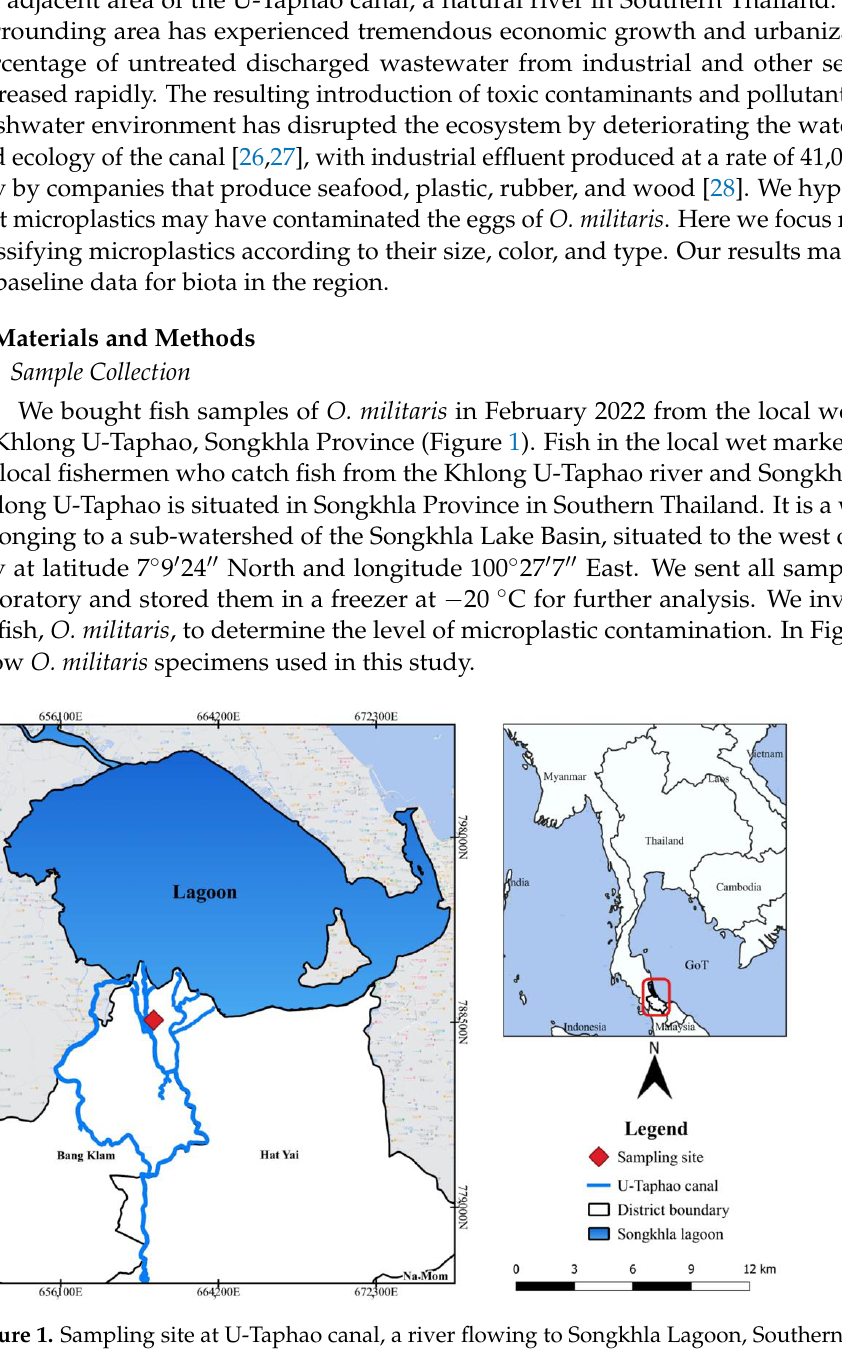
Figure 2 . Fish samples in the study : ( A ) O . militaris or soldier catfish; ( B ) fish eggs randomly picked from mother catfish; ( B1 ) fish eggs taken from mother catfish; ( B2 ) each fish egg carefully separated ; ( B3 ) appearance of a fish egg under a microscope . 2 . 2 . Laboratory Analysis 2 . 2 . 1 . Part of the Observed Microplastic in the Gills, Stomach, and Tissue of Fish In the laboratory, we defrosted the fish samples ( n = 40 ) at room temperature before the examination . We measured and recorded the biological characteristics of O . militaris , including total length ( cm ) , standard length ( cm ) , and mouth length ( cm ). Subsequently, we dissected each fish to remove the tissue ( n = 40 ) , stomach ( n = 40 ) , and gills ( n = 40 ) and then placed them in 250 mL glass beakers filled with distilled water . We recorded the total weight ( g ) of each fish before removing the samples from the stomach . We weighed the